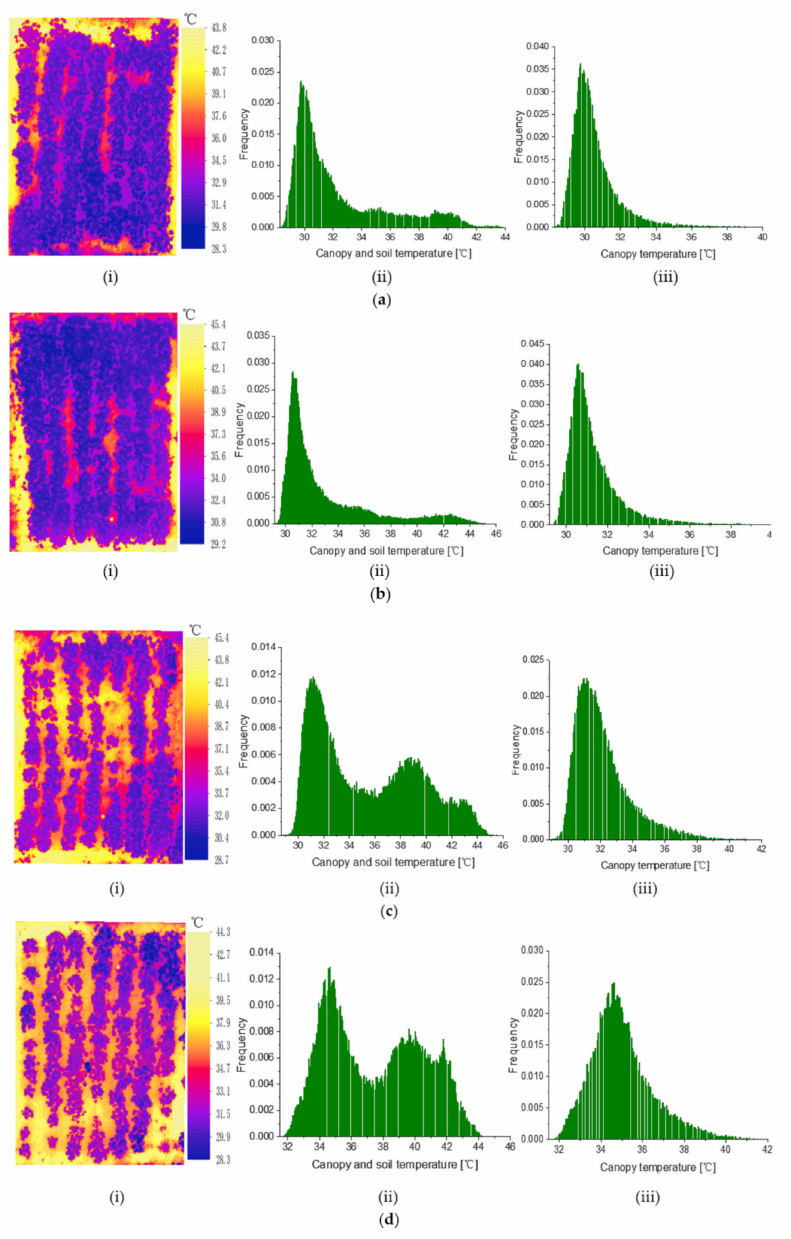
Figure 5. ( a – d ) Histograms of the temperature from the cotton canopy and soil pixels and histograms of the temperature from the cotton canopy pixels only for each treatment plot; (i) Original thermal infrared image, (ii) Temperature histogram (canopy and soil pixels), and (iii) canopy temperature histogram (cotton canopy pixels) for the T 1 ( a ), T 2 ( b ), T 3 ( c ), and T 4 ( d ) treatment plots. Note: the white lines of histogram represent null temperature